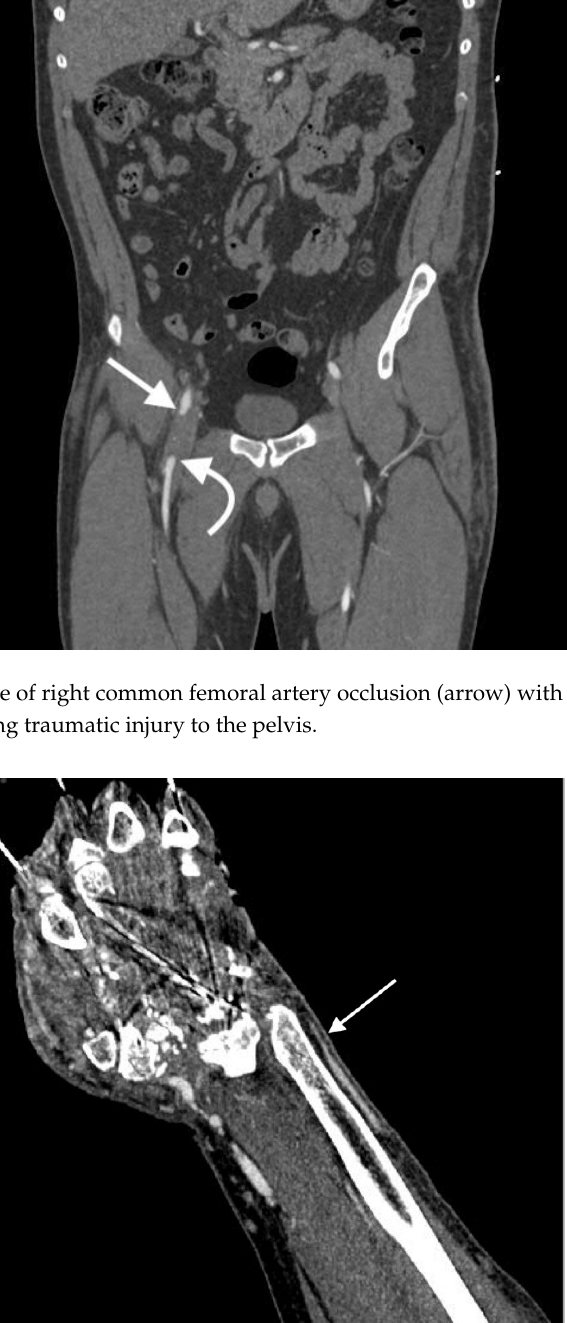
Figure 5. Coronal image of right distal ulnar artery stenosis following traumatic injury to the wrist and hand.